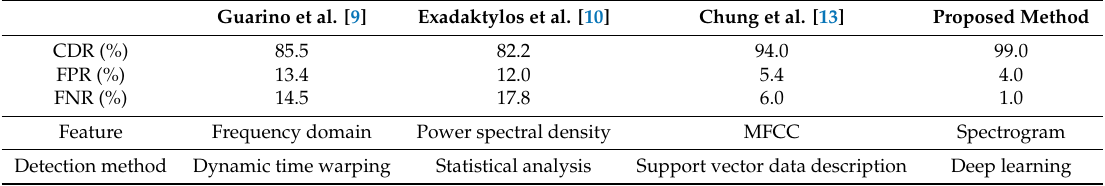
Table 7. Performance comparison between proposed method and other disease detection studies regarding cough